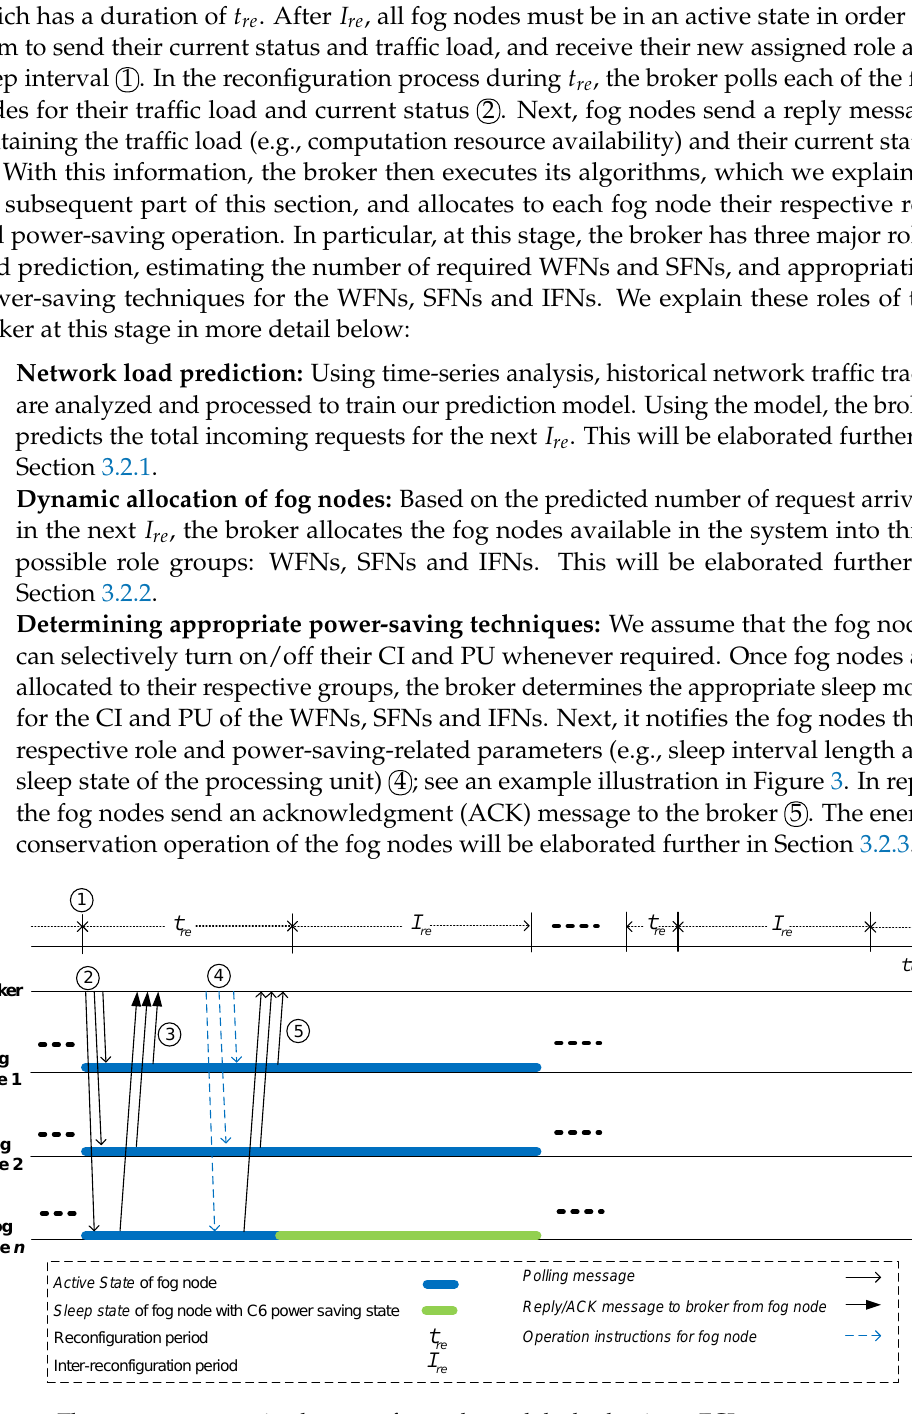
Figure 2. The processes occurring between fog nodes and the broker in an